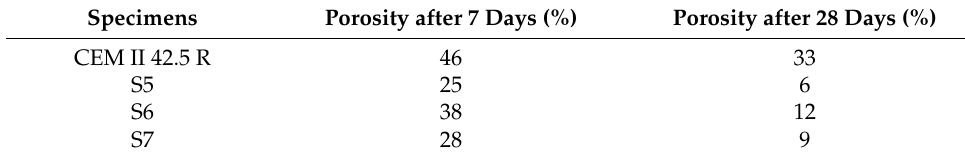
Table 4. X-ray computed tomography to analyze the porosity of mortar samples after 7 and 28 days.